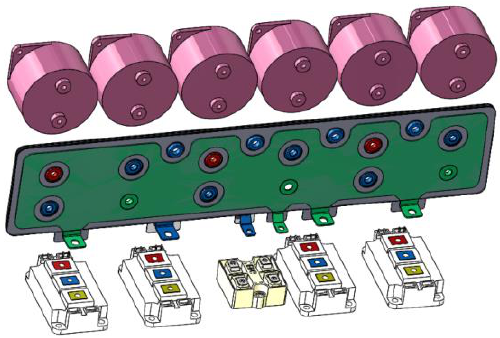
Figure 16. The exploded diagram of laminated busbar, switches and capacitors.